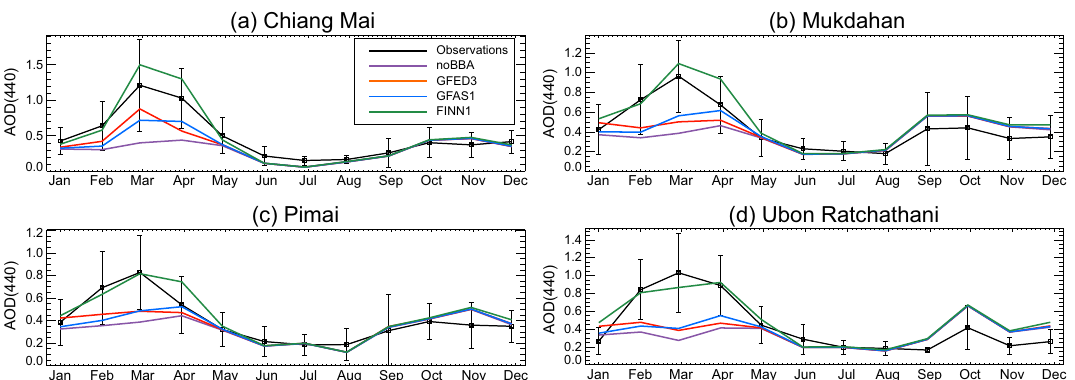
Figure 9. Average seasonal cycles in observed (black) and simulated (colour) monthly mean AOD at 440nm at four AERONET stations in the Thailand: (a) Chiang Mai Met. Station, (b) Mukdahan, (c) Phimai, and (d) Ubon Ratchathani. Multi-annual monthly mean concentrations were calculated by averaging over all years of available daily mean observation data between January 2003 and December 2011. The modelled results are shown for four simulations: without biomass burning (purple), and with GFED3 (red), GFAS1 (blue) and FINN1 (green) fire emissions. The error bars show the standard deviation of the mean of the